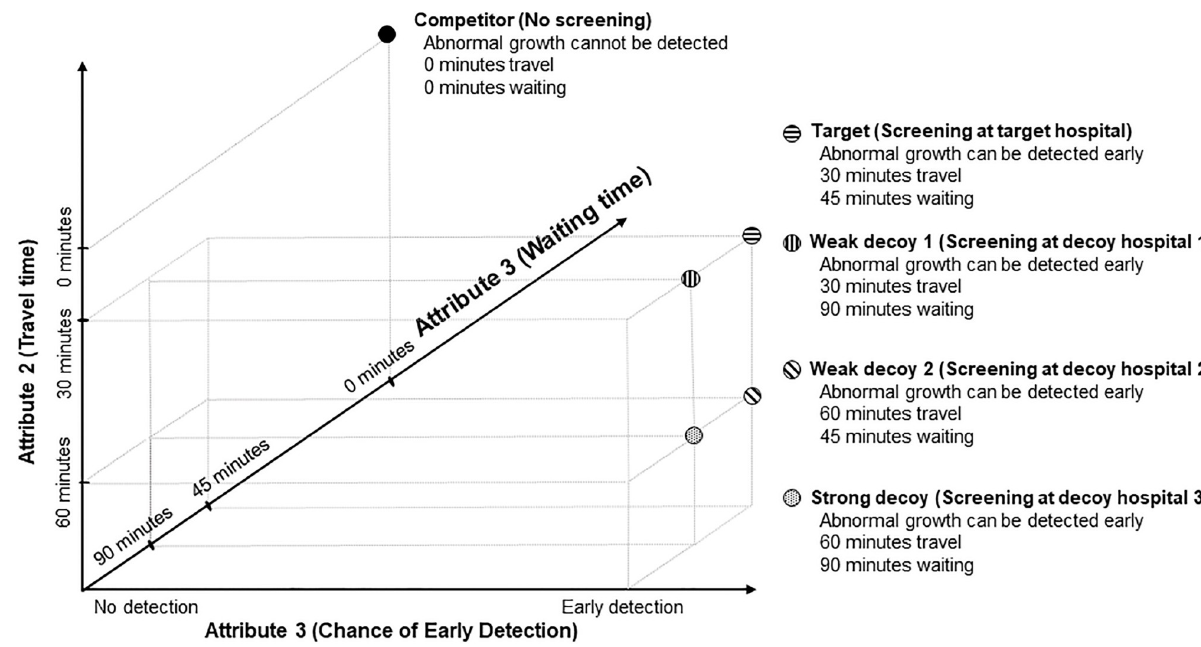
Fig 4. Implementation of the decoy effect in Study